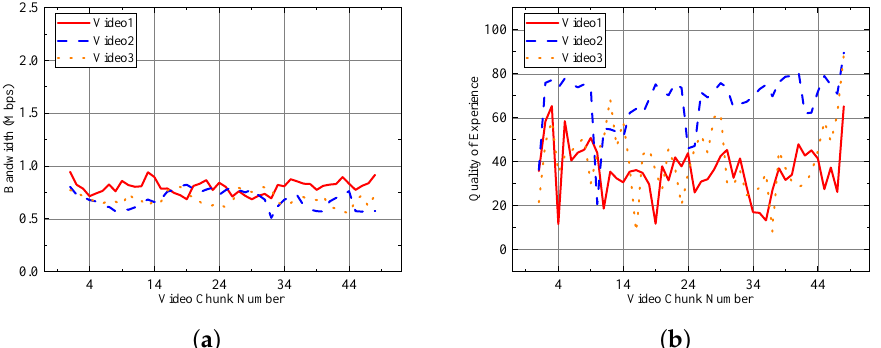
Figure 4. ( a ) Evolution of bandwidth in MPC ( b ) Evolution of QoE in MPC.